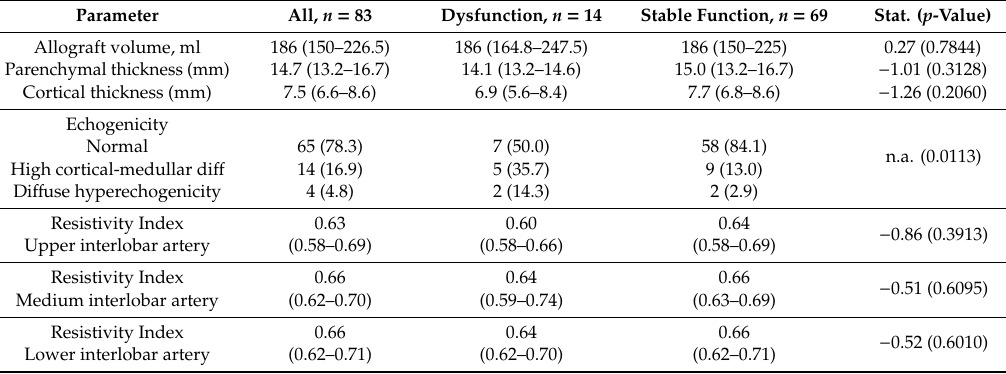
Table 3. Grey-scale and Doppler ultrasound